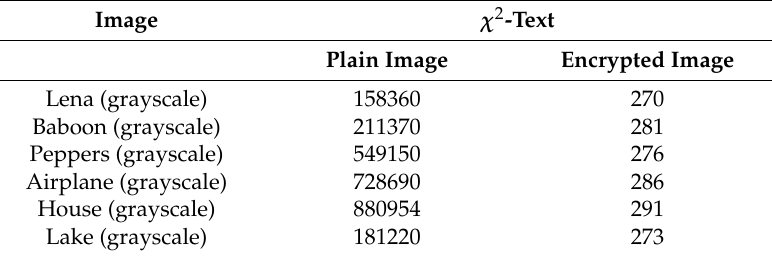
Table 4. Chi-squared test results for histogram